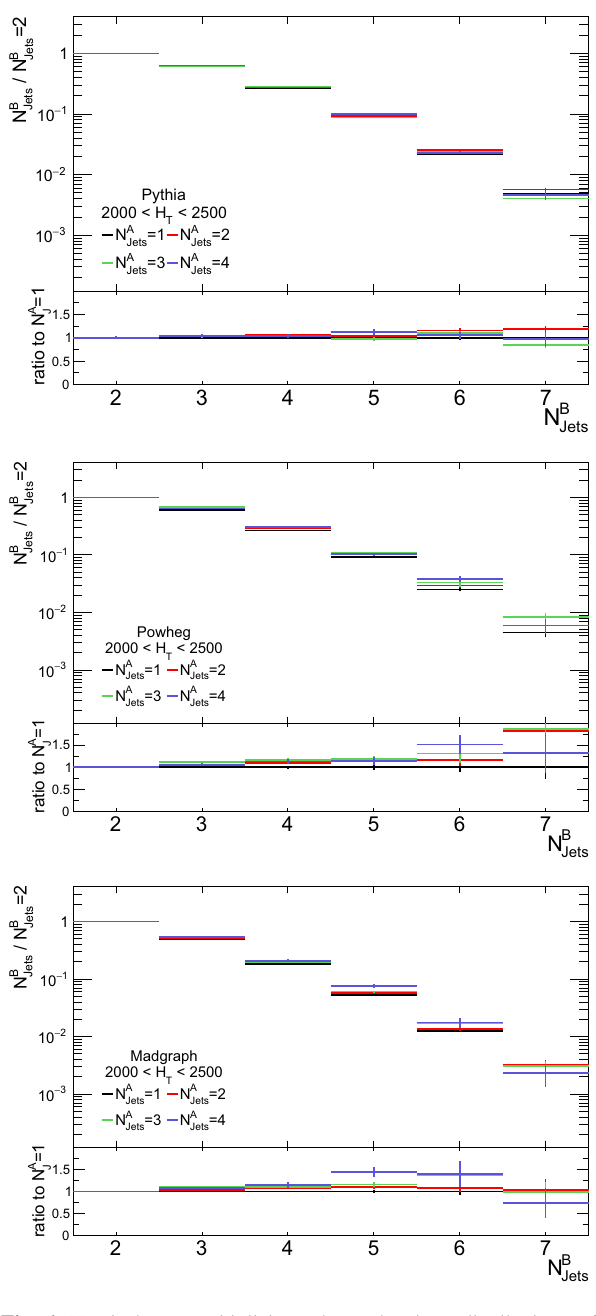
Fig. 6 Hemisphere multiplicity plots showing distribution of N B while N A constrained to 1 (black), 2 (red), 3 (green) and 4 Jets Jets (blue). Events were generated by Pythia (top), Powheg (center) and Madgraph (bottom). Events are selected such that 2 < H T < 2.5 TeV and all jets has p T > 50 GeV and | η | < 2 . 8. The results are practi- cally independent of these three selection criteria. Events are divided into two hemispheres using the Thrust axis. For visual comparison, all distributions normalized such that content of the N B equals